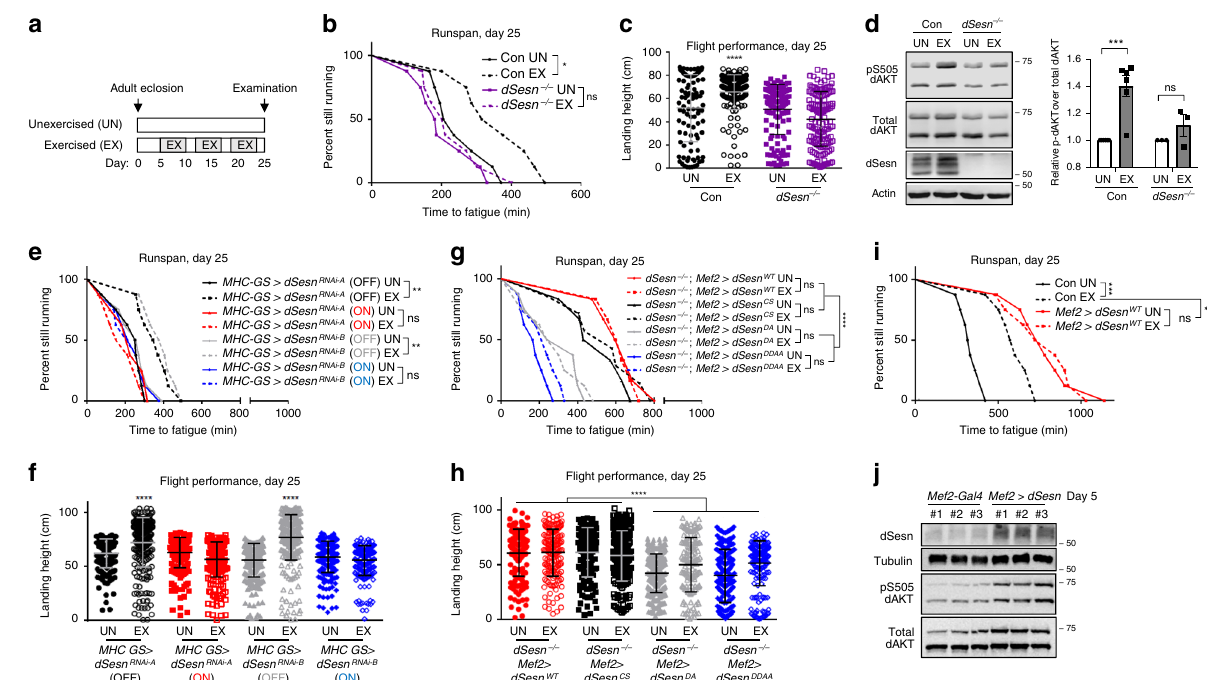
Fig. 1 Sestrin is critical for exercise response in Drosophila . a Schematic of exercise training in Drosophila . Gray boxes indicate days with control (UN) or exercise (EX) treatments. b – d Wild-type (Con; w 1118 ) and dSesn -null ( dSesn − / − ) fl ies were analyzed. e , f Two independent RNAi constructs targeting dSesn were conditionally expressed in muscle tissue using myosin heavy chain-gene switch ( MHC-GS ) driver, controlled by mifepristone feeding (ON/OFF). g – j Wild-type, C86S, D423A, D423A/D424A dSesn transgenes were expressed in muscle of dSesn − / − fl ies ( g , h ) or WT fl ies ( i ). C86, D423 and D424 in dSesn correspond to C125, D406 and D407 in Sesn2. Flies were analyzed by runspan ( b , e , g , i ) or fl ight performance ( c , f , h ) assays. In fl ight performance graphs, closed and open shapes indicate individual data from control (UN) and exercised (EX) experiments, respectively. Endogenous dSesn was overexpressed through EP line version of UAS-dSesn ( j ). Leg and thoracic muscle were analyzed by immunoblotting ( d, j ) and band densitometry ( d , right; values relative to corresponding UN levels). Biologically independent animal groups: n = 8 ( b , e , i ; groups of 20 fl ies), n = 6, 6, 3, 3 ( d , left to right; groups of 20 fl ies), n = 6, 6, 6, 7, 8, 8, 8, 8 ( g , upper to lower; groups of 20 fl ies). Biologically independent animals: n = 100, 193, 141, 145 ( c , left to right), n = 196, 264, 250, 233, 257, 288, 218, 234 ( f , left to right), n = 149, 159, 144, 187, 223, 148, 233, 237 ( h , left to right). Error bars, s.d. ( fl ight performance) or s.e.m. (immunoblot quanti fi cation). * P < 0.05, ** P < 0.01, *** P < 0.001, **** P < 0.0001 or ns, non-signi fi cant from a log-rank test (runspan) or two-tailed student ’ s t test (all other assays). Molecular weight markers are indicated in